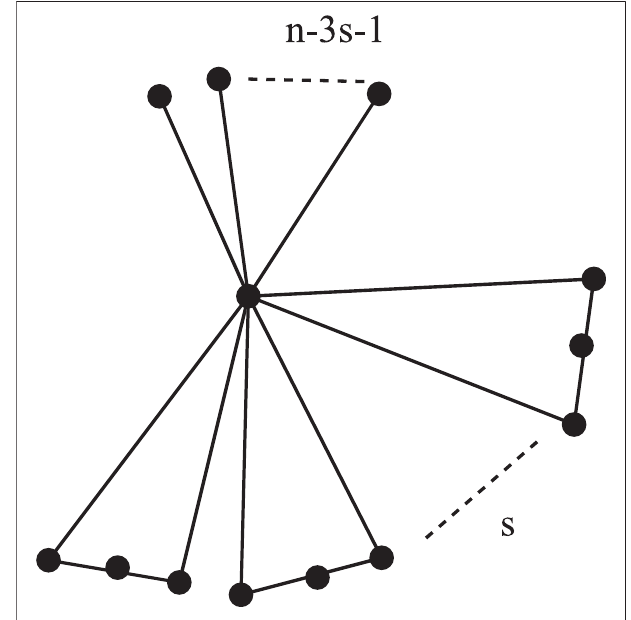
FIGURE 1 | Graph (cid:14) C ( n , s ) , for n ≥ 3 s + 2, s ≥ 2 and for n ≥ 9, s (cid:2)